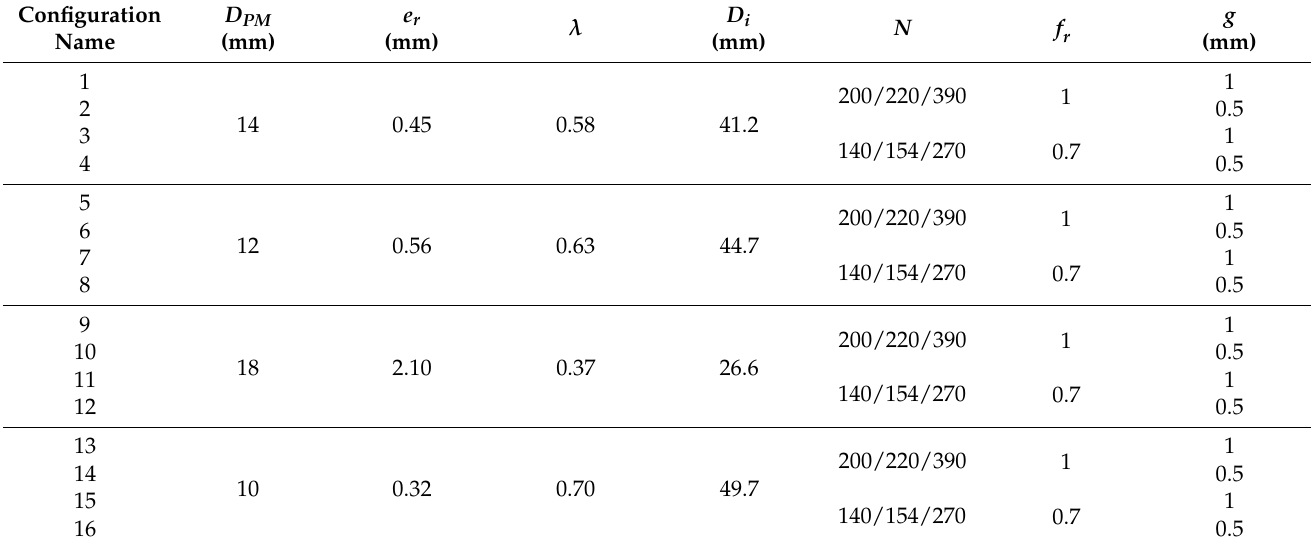
Table 4. AFPMGS configurations.